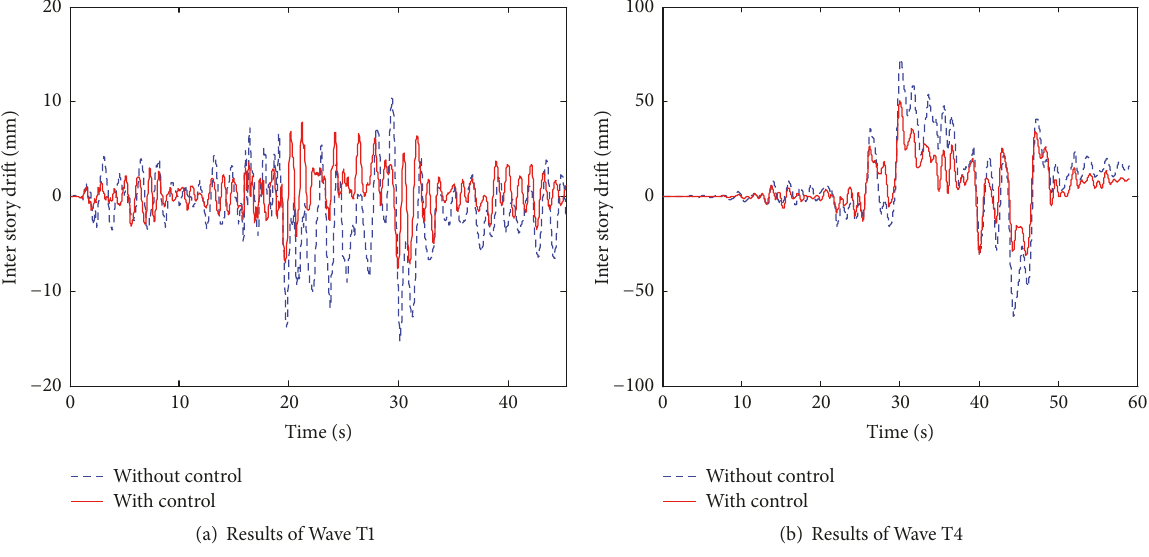
Figure 21: Interstory drift time history of different